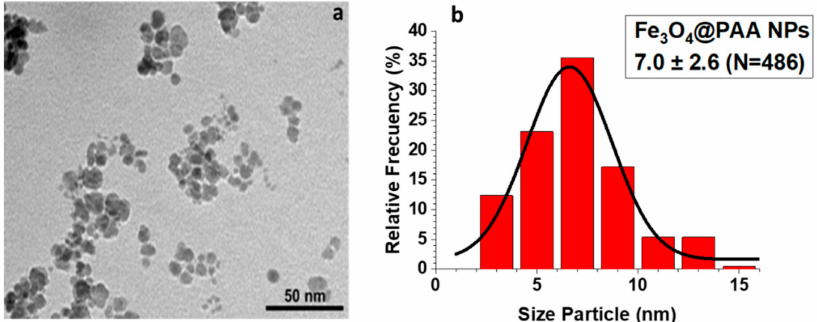
Figure 4. ( a ) Transmission electron microscopy (TEM) micrograph and ( b ) size distribution of the Fe 3 O 4 @PAA nanoparticles. The size distribution was performed by measuring a sample consisting of 486 magnetic nanoparticles with the ImageJ